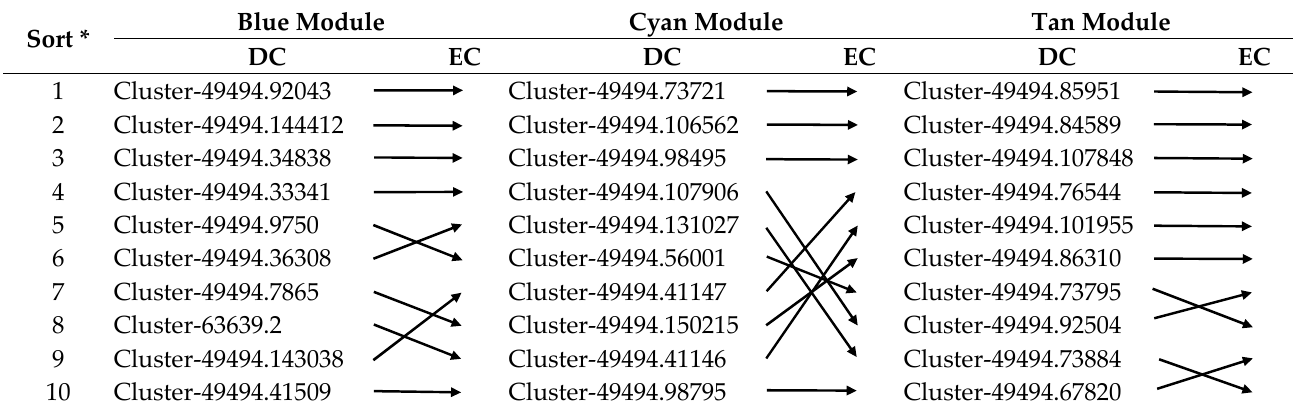
Table 1. Calculating the degree centrality (DC) and eigenvector centrality (EC) indices of each gene in the three modules using CytoNCA.